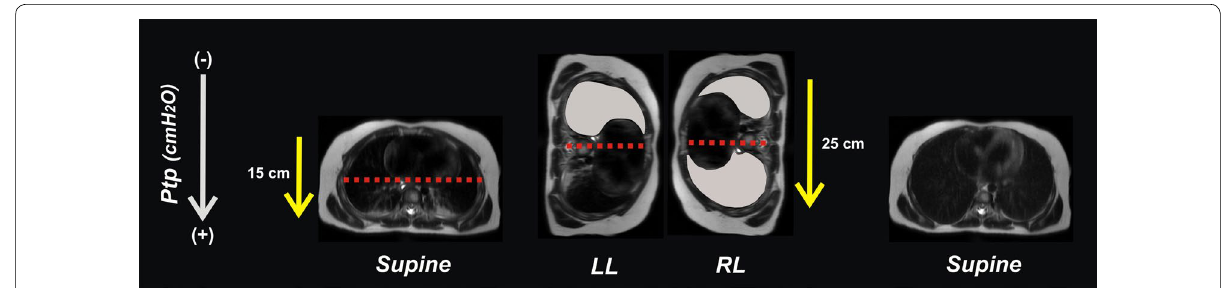
Fig. 1 Concept of postural lung recruitment. Theoretical explanations of the postural recruitment maneuver in an anesthetized child 6 years of age. The maneuver consists of sequential changes in body position from supine to both lateral positions and back to supine again, keeping ventilatory settings constant. The gradient of trans-pulmonary pressures (Ptp) differs between body positions due to the elliptical shape of the chest with the gravity-dependent thoracic dimension being larger in lateral than in the supine position (yellow arrows). Thus, the lower half of the lungs is predis- posed to collapse while the upper half is usually aerated and “open” during the entire respiratory cycle (red dotted line). In the left lateral position (LL), the entire right upper lung has the chance to open up at a low plateau pressures even under standard ventilator settings (gray lung). Once open, this right lung can maintain its “open lung” condition when turned to the right lateral positioning (RL) provided sufficient PEEP is applied. Notice the larger vertical distance in the lateral position required a higher PEEP to counteract the potential decrease in Ptp in the dependent lung. Now, the left lung is being recruited as it is placed in the uppermost gravity non-dependent position. At the end of the postural recruitment maneuver both lungs are free from atelectasis although the patient has returned to the baseline supine